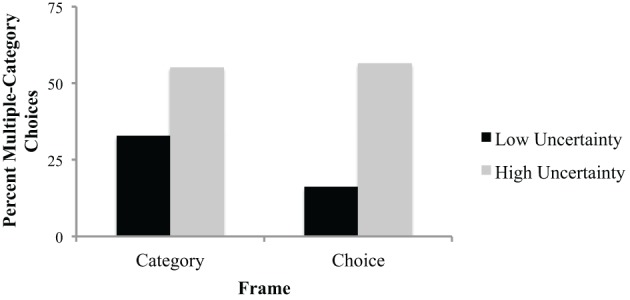
Mean percent of multiple-category choices as a function of frame and category uncertainty, Experiment 1.